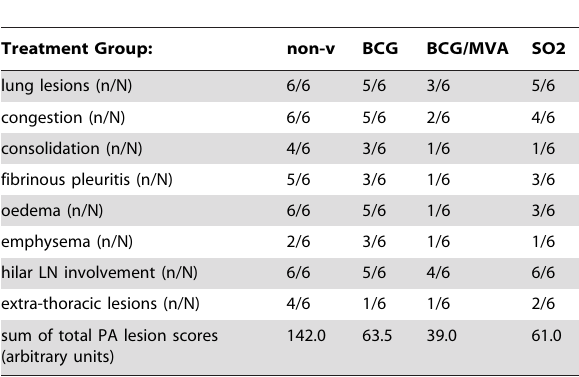
Table 2. Summary of frequencies of TB-associated pathologic manifestations and total lesion scores per treatment